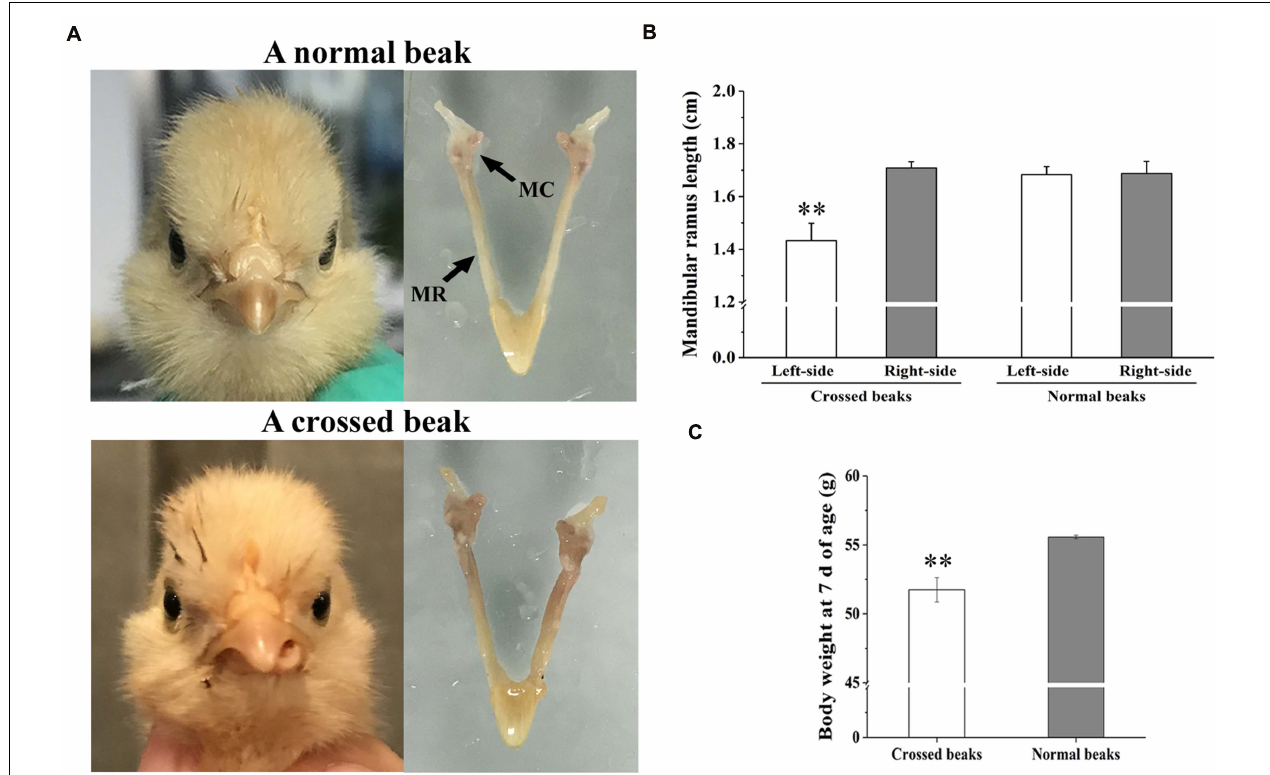
FIGURE 1 | Morphology, mandibular ramus length, and body weight of chicks at 7 days of age. (A) Morphological observation of mandible in a normal beak chick and a crossed beak chick (Shi et al., 2020) with left mandibular curvature. MC means mandibular condyle; MR means mandibular ramus. (B) The length of bilateral mandibular ramus of crossed beaks with left mandibular curvature ( n = 16) and normal beaks ( n = 16). Results are expressed as means ± standard deviation, means were compared by Student-Newman-Keuls multiple-range tests. (C) Body weight of 7 day-old chicks with crossed beaks ( n = 16) and normal beaks ( n = 16). The body weight was analyzed using t -test, ** represents p <